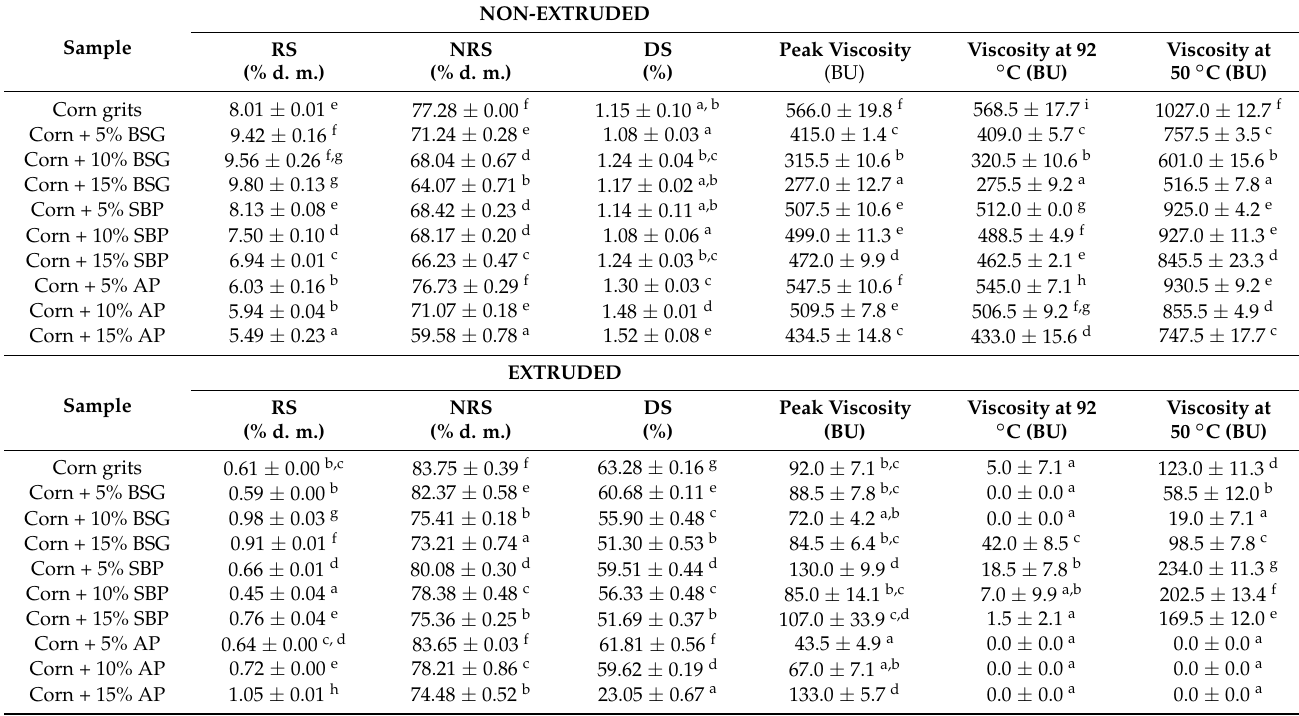
Table 3. Starch content, starch damage and pasting properties of non-extruded and extruded